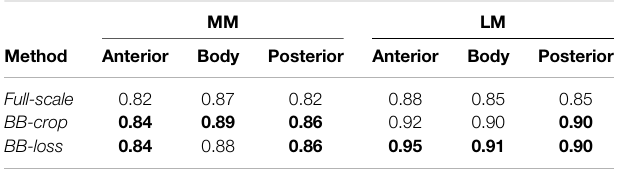
The best results for each anatomical sub-region are highlighted in bold.